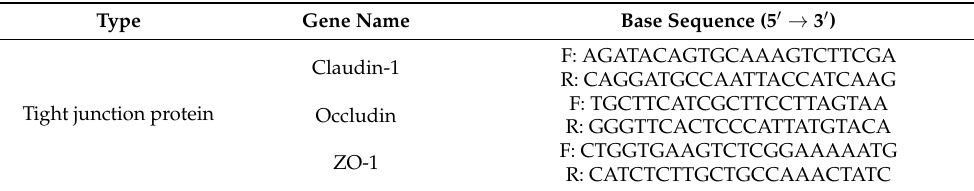
Table 1. The information on the